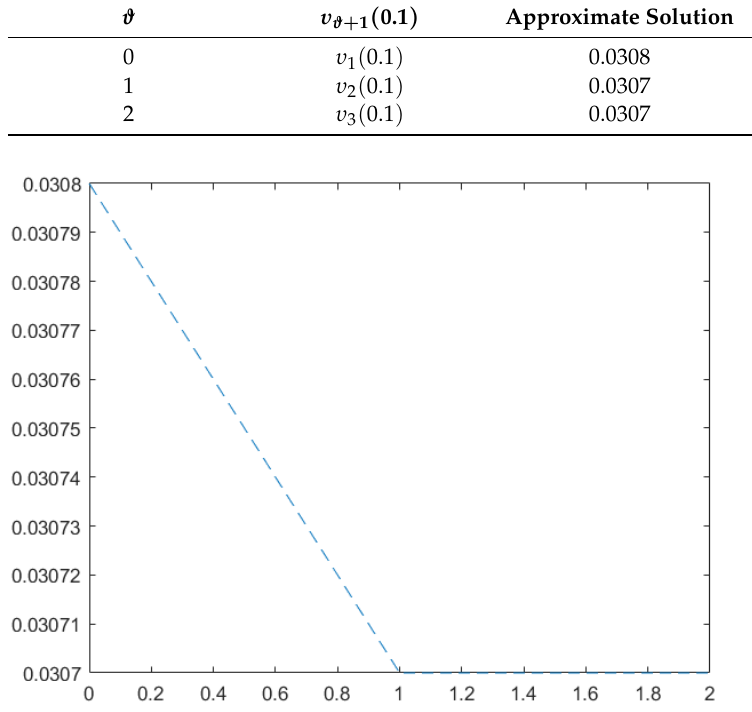
Figure 1. Interpolated graph for η =